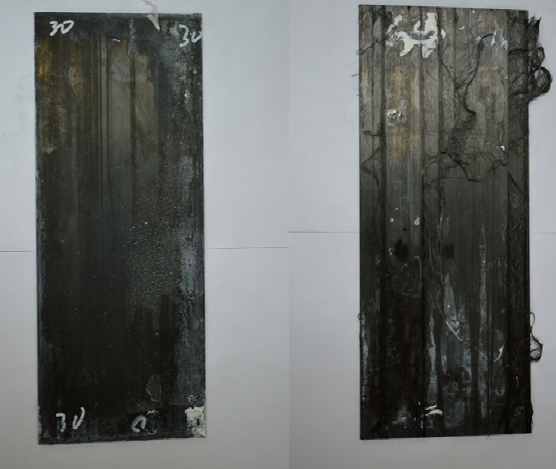
Figure 6. Coated specimen (left side) and naked specimen (right side) immersed in 60 °C alkaline solution for 135 days.